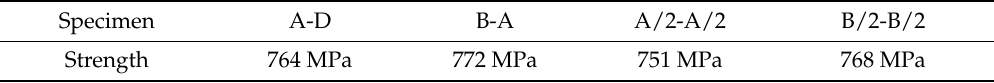
Table 6. The effective strength of notched specimen with different architecture across the gauge section.